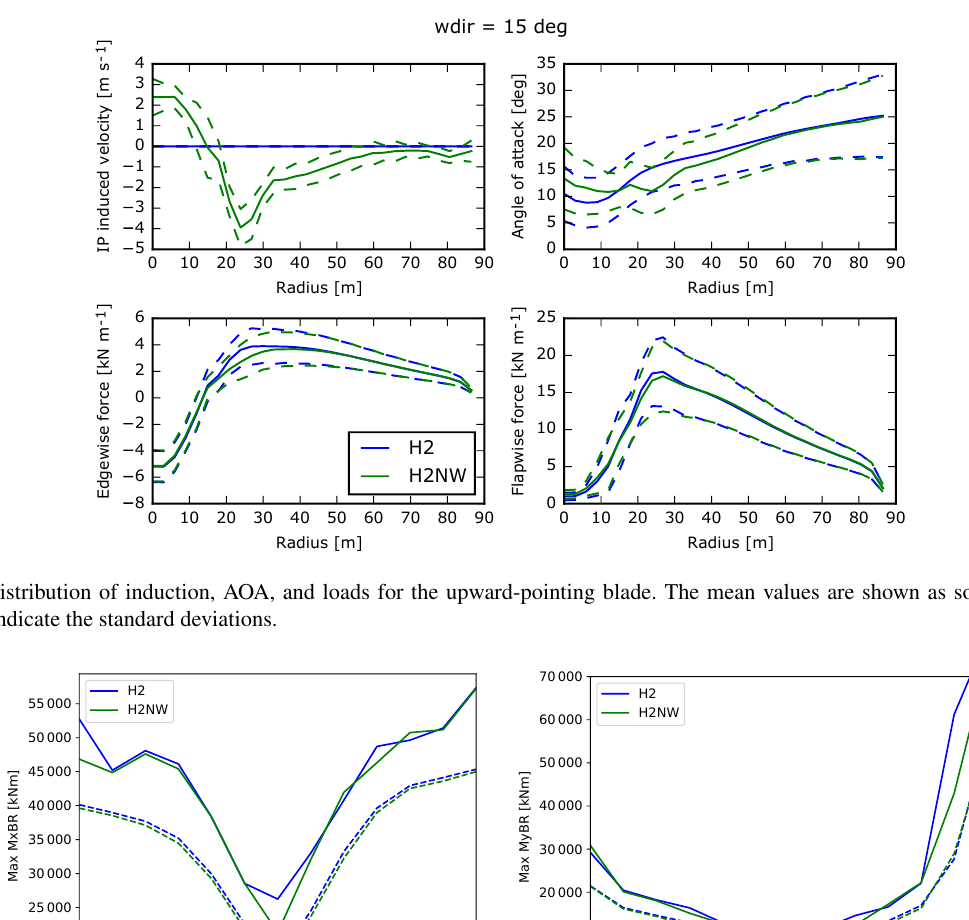
root bending moment. The result of these simulations is shown in Fig.